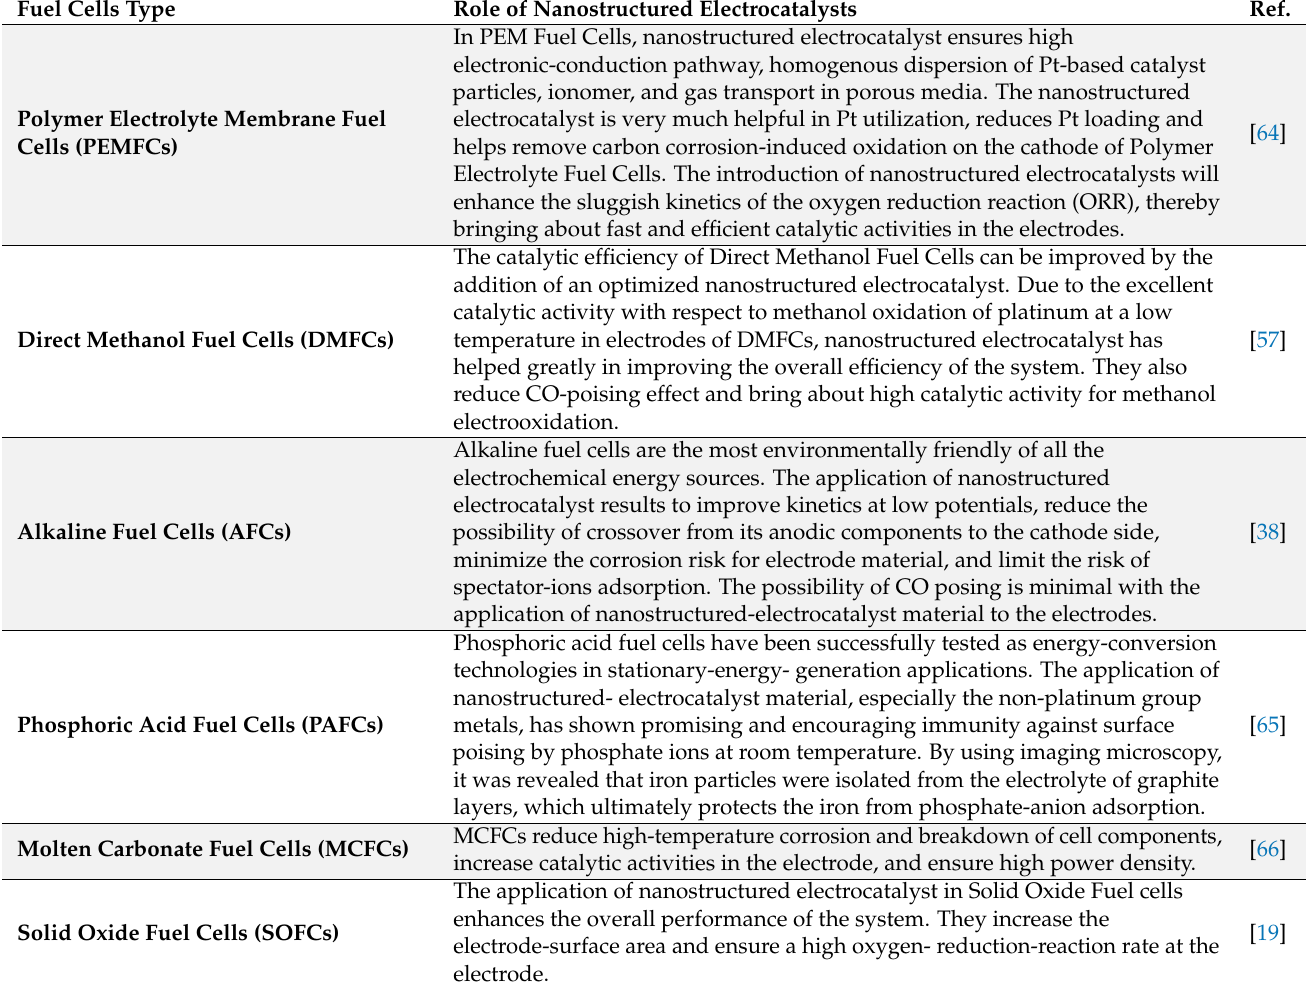
Table 1. List of nanostructured electrocatalysts used in various fuel cells. Fuel Cells Type Role of Nanostructured